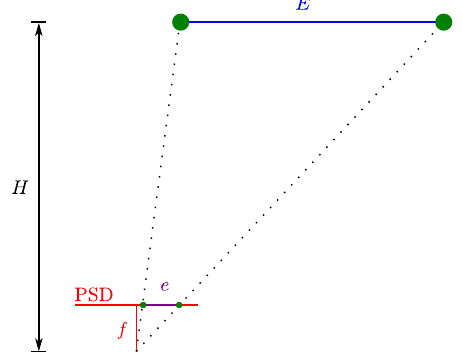
Figure 11. Diagram showing the correspondence between errors on the surface of the PSD and positioning